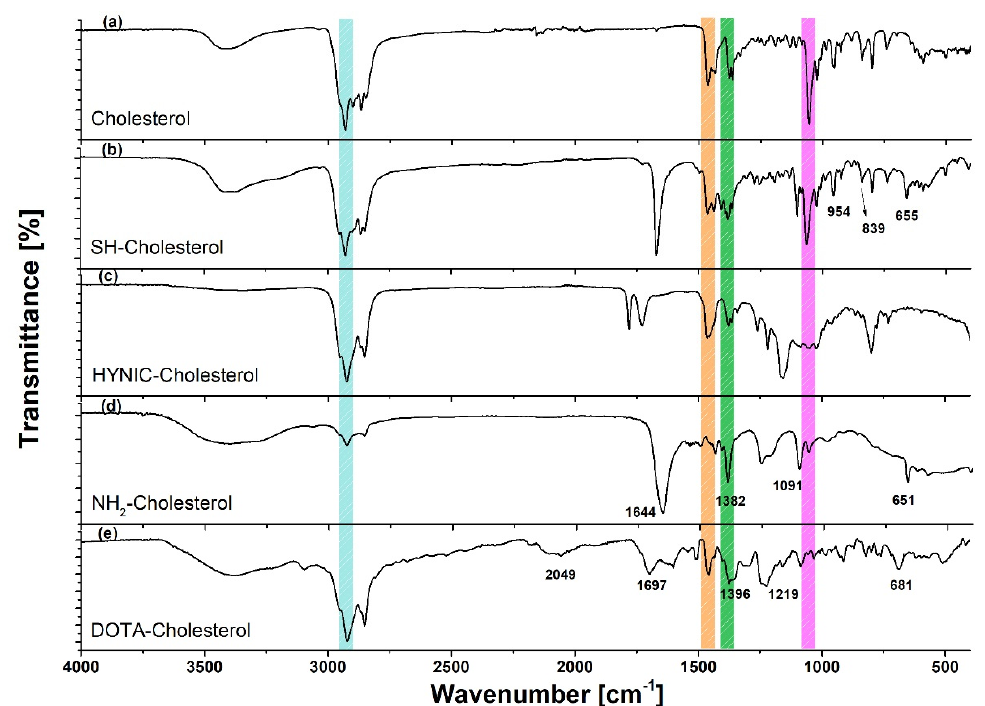
Figure 3. Infrared spectra of cholesterol and derivatives: raw material (cholesterol), SH-(CH 2 ) 3 -S- Cholesterol (SH-Cholesterol), HYNIC-S-(CH 2 ) 3 -S-Cholesterol (HYNIC-Cholesterol), NH 2 -(CH 2 ) 2 - NH-Cholesterol (NH 2 -Cholesterol), and DOTA-benzene- p -SC-NH-(CH 2 ) 3 -NH-Cholesterol (DOTA- Cholesterol).